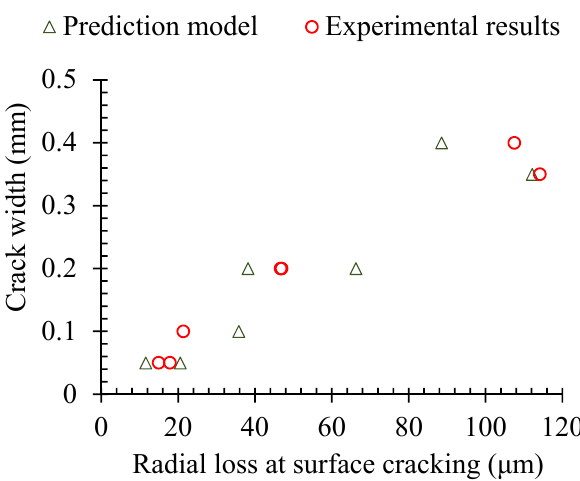
Figure 9. Relationship of the pitting corrosion and the crack width.